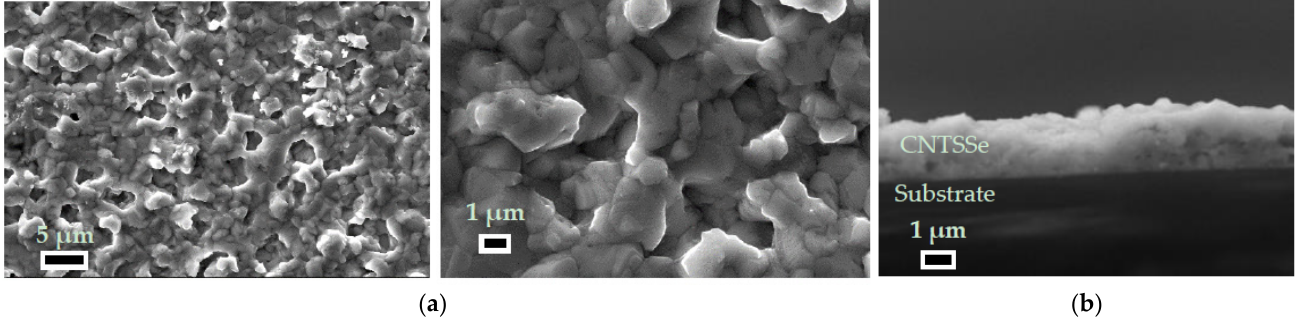
Figure 4. The top view ( a ) and cross-section ( b ) SEM mapping images of the CNTSSe thin films on a glass/Mo substrate.